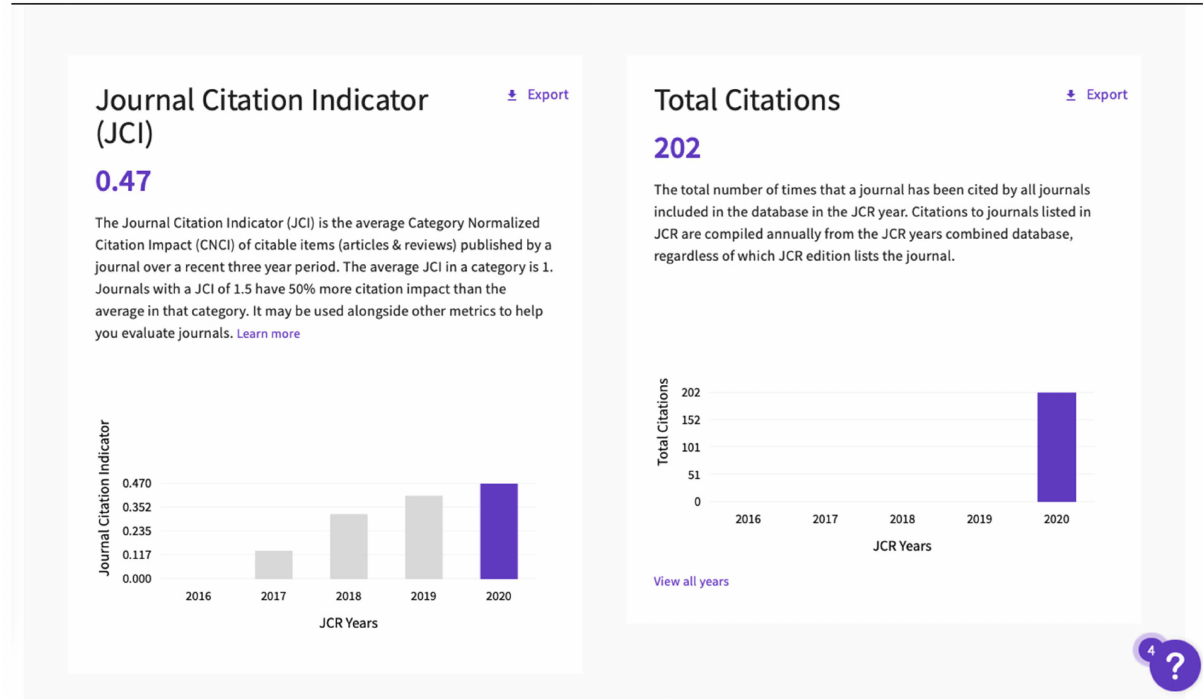
Figure 13. The JCI value of the analysed journal ( left ) and the citations ( right ). In 2020, the JCI was first assigned to the journal, but there are also visible projections of that value in the past (2017–2019).